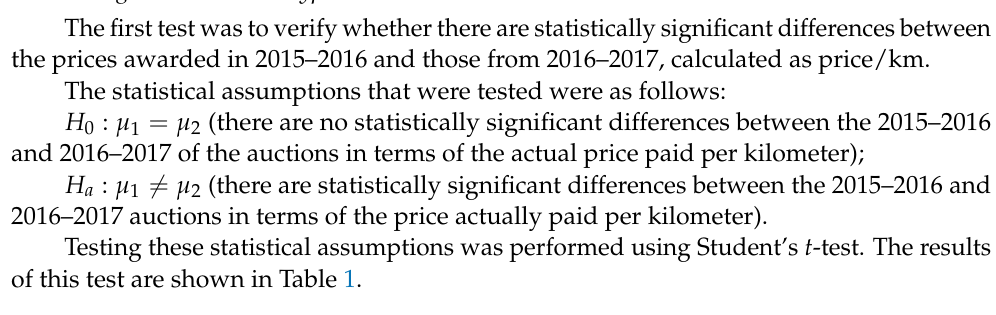
Table 1. Paired test.